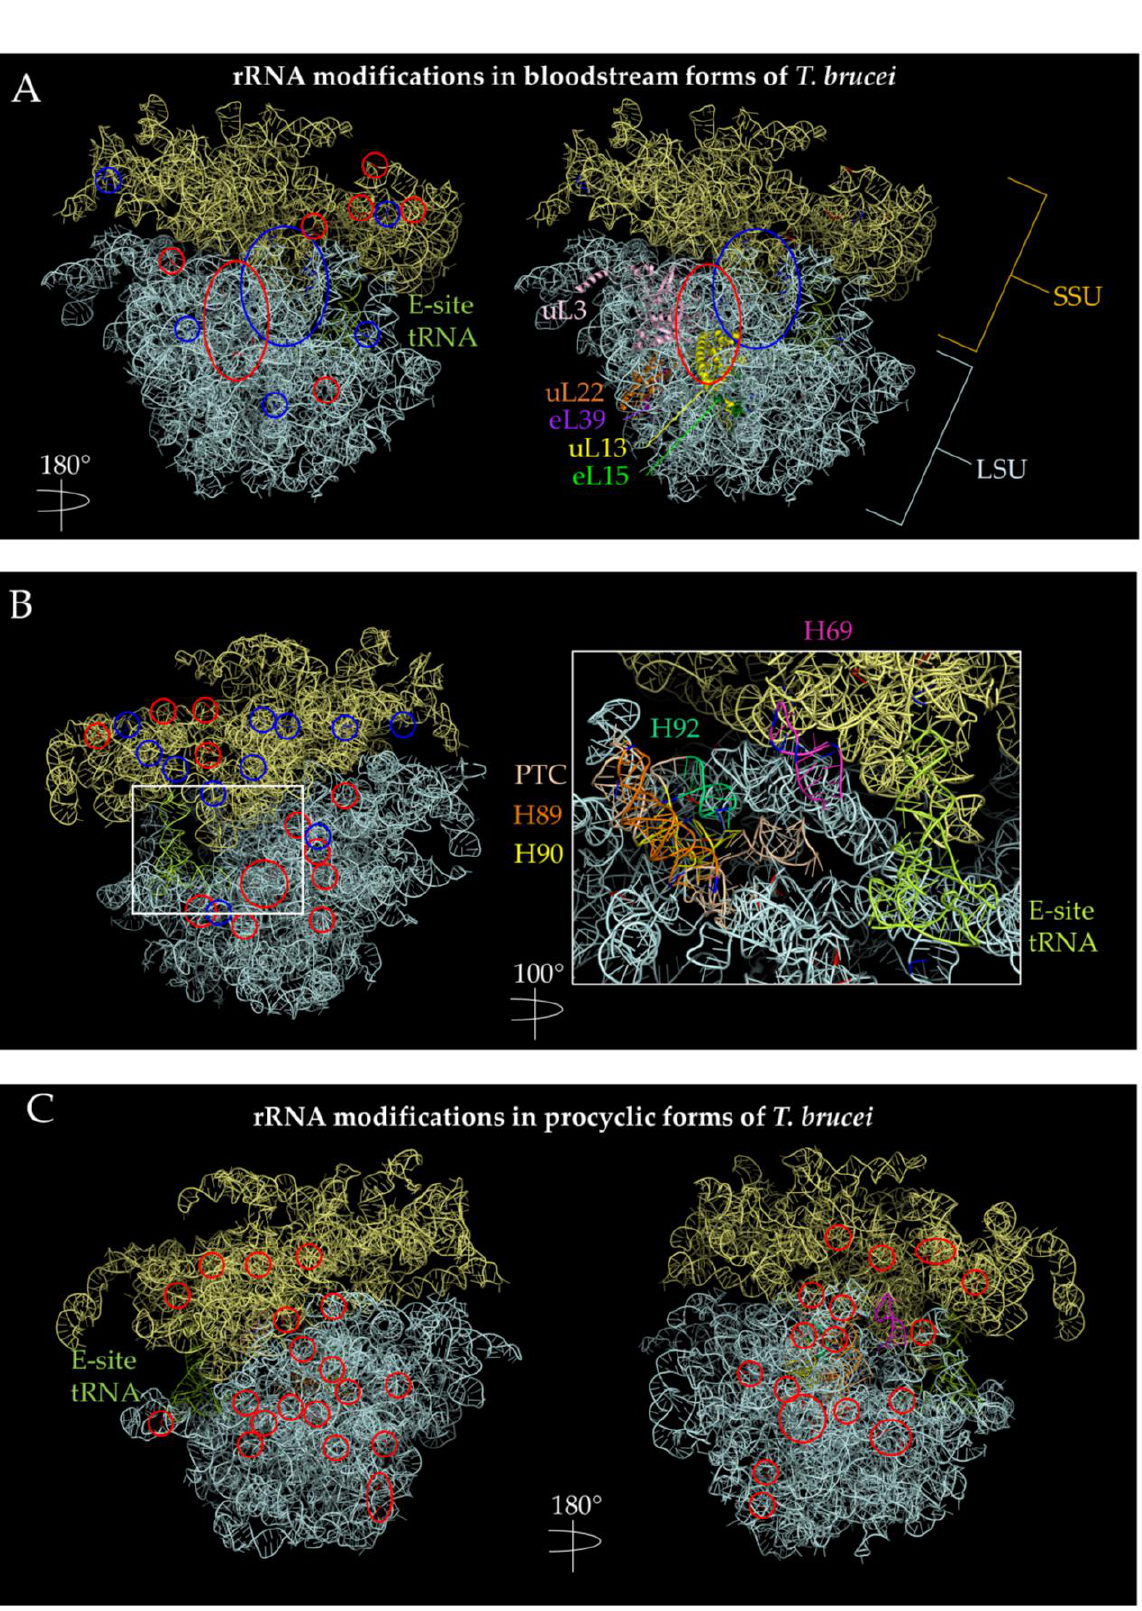
Figure 4. Positions of the rRNA with hyperpseudouridylations and increased 2 ′ -O-methylations in bloodstream forms (BSF) and procyclic forms (PCF) of T. brucei . PDB 4V8M [104] ribosome structure were used to visualize methylation and pseudouridylation sites using PyMOL [110]. The SSU is indicated by pale yellow, while the LSU is indicated by pale cyan. Methylation sites are circled in red, while pseudouridylation sites are indicated in blue. ( A ) Methylation and pseudouridylation